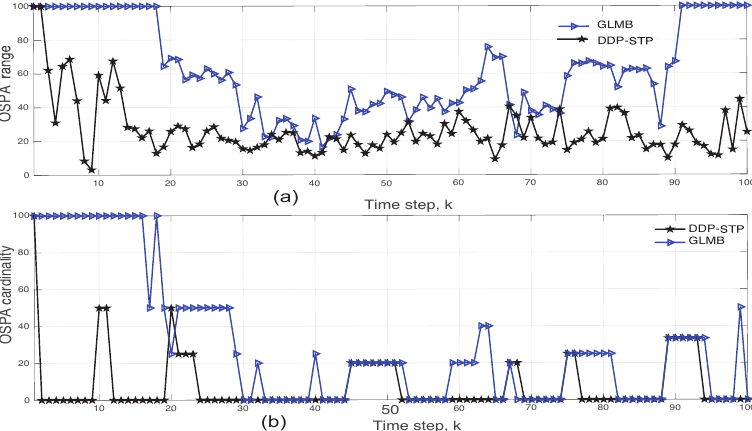
Figure 7. OSPA ( a ) range and ( b ) cardinality using DDP-STP and GLMB in Experiment 2. Experiment 3. DDP-STP for tracking multiple objects under varying SNR. We demonstrate the effect of varying the SNR when tracking multiple targets using DDP-STP. In this experiment, we assume that 11 objects enter and leave the scene at different times, as shown by the true object cardinality in Figure 8. We use ω k = 0 and assume that only range measurements are available. The tracking was simulated for − 3 dB, − 5 dB and − 10 dB SNR using NIW ( 0, 0, 100, I ) for G 0 and Γ ( 1, 0.2 ) for α . The estimated cardinality is compared to the true one for decreasing SNR in Figure 8a–c. As expected, the performance of the DDP-STP decreases as the SNR decreases. Figure 9a,b compare the OSPA range and OSPA cardinality performance as the SNR